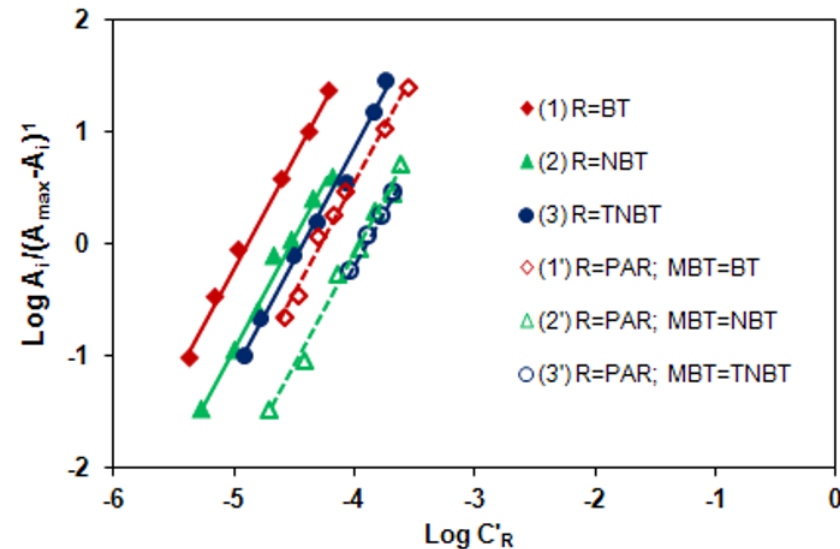
Figure 6. Straight lines obtained by the mobile equilibrium method [36] during the determination of MBT-to-In(III) (1-3) and PAR-to-In(III) (1‘-3‘) molar ratios from the experimental data given in Fig. 4 and 3, respectively. Straight line equations: (1) y=1.99x+9.77; (2) y=1.98x+8.99; (3) y=2.00x+8.85; (1’) y=1.98x+8.47; (2’) y=2.00x+7.88; (3’) y=1.99x+7.80. Table 3. Determination of the PAR-to-In(III) and MBT-to-In(III) molar ratios (n and m, respectively) by the Asmus method [37] from the experimental data given in Fig. 3 and 4, respectively. Extraction system Correlation coefficient squared values (CC 2 ) corresponding to molar ratios 1, 2 and 3 PAR:In(III) MBT:In(III)